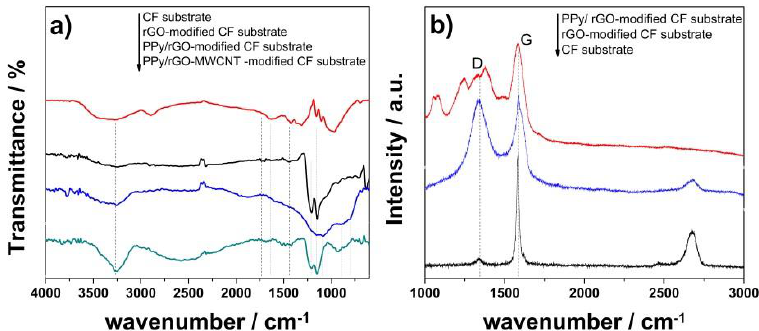
Figure 2. Fourier Transform InfraRed (FTIR) spectra of carbon fiber (CF) substrate before and upon coating with varying PPy/rGO:MWCNT coatings ( a ) and Raman spectra of activated CF substrate before and after coating with rGO and PPy/rGO, respectively ( b ).